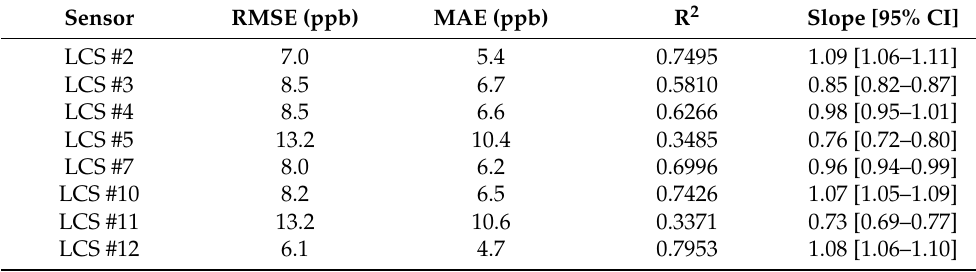
Figure 7. Scatter plot of hourly LCS #2 Clarity 15-day calibration NO 2 vs. West Phoenix FRM NO 2 with trendline equation and R 2 , 1:1 line in black. Table 3. Data summary for the Clarity 15-day calibration data from the 8 LCS collocated at West Phoenix over the entire deployment period, calculated using West Phoenix FRM NO 2 data.